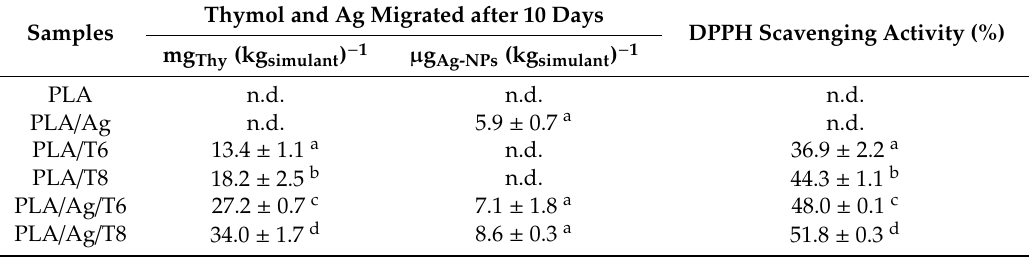
Table2. ThymolandAgrelease(ethanol10%(v / v)after10daysat40 ◦